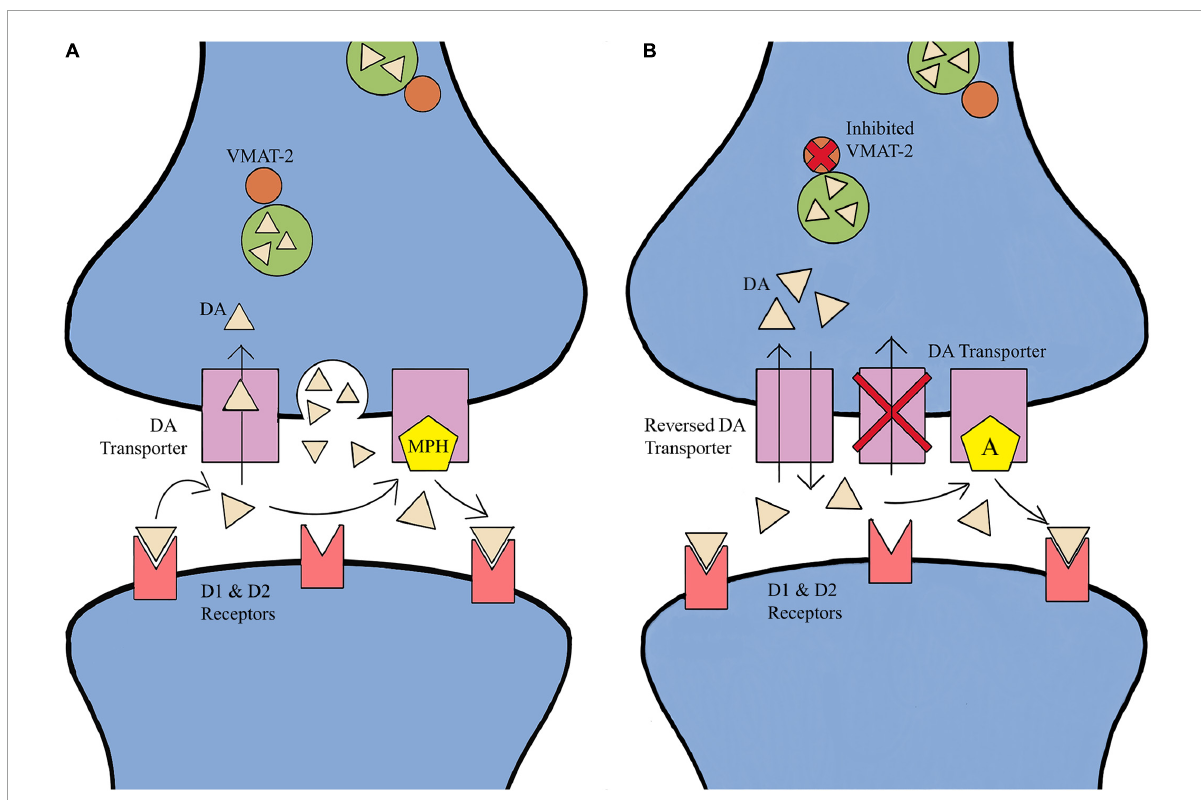
FIGURE1 Effects of methylphenidate (MPH) and amphetamine (A) on neurotransmitter (NT) reuptake. (A) MPH inhibits NT transporters from reuptake into the presynaptic cell, increasing extracellular concentrations and increasing possible receptor binding. MPH treatment is shown to decrease NT transporter density in the striatum, thereby increasing the transportation of vesicular NT via vesicular monoamine transporter-2 (VMAT-2), leading to more NT within the synapse. (B) Amphetamine inhibits NT transporters in the reuptake of NT into the presynaptic cell and increases extracellular concentrations of NT in multiple brain regions. The increase in NT like dopamine concentrations within the synapse increases the incidence of receptor binding. Amphetamine is distinct from MPH in two ways: the inhibition of VMAT-2 results in the release if dopamine into the presynaptic terminal by presynaptic vesicles, and the internalization of a dopamine transporter resulting in the reversal of the transporter from in-flow to dual-flow of dopamine reuptake (Smith, 2003; Minzenberg, 2012; Volkow and Swanson, 2013; Chabreck, 2015; Stewman et al., 2018; Berezanskaya et al.,